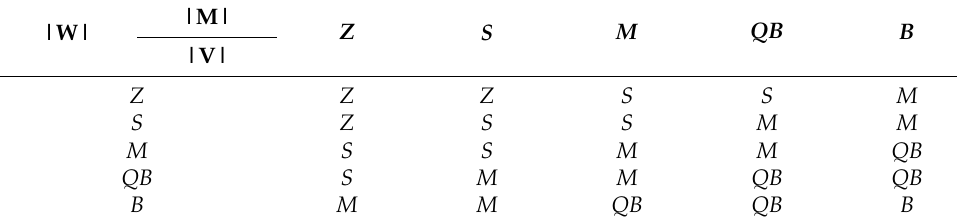
Table 2. Fuzzy rule base for